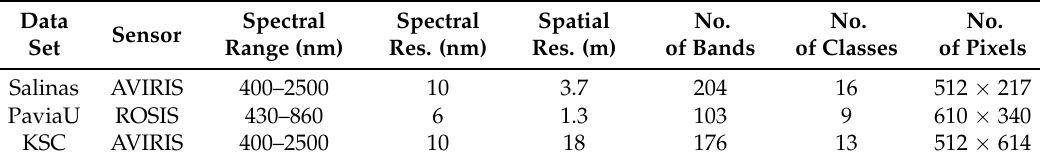
Table 1. The original information of the three data